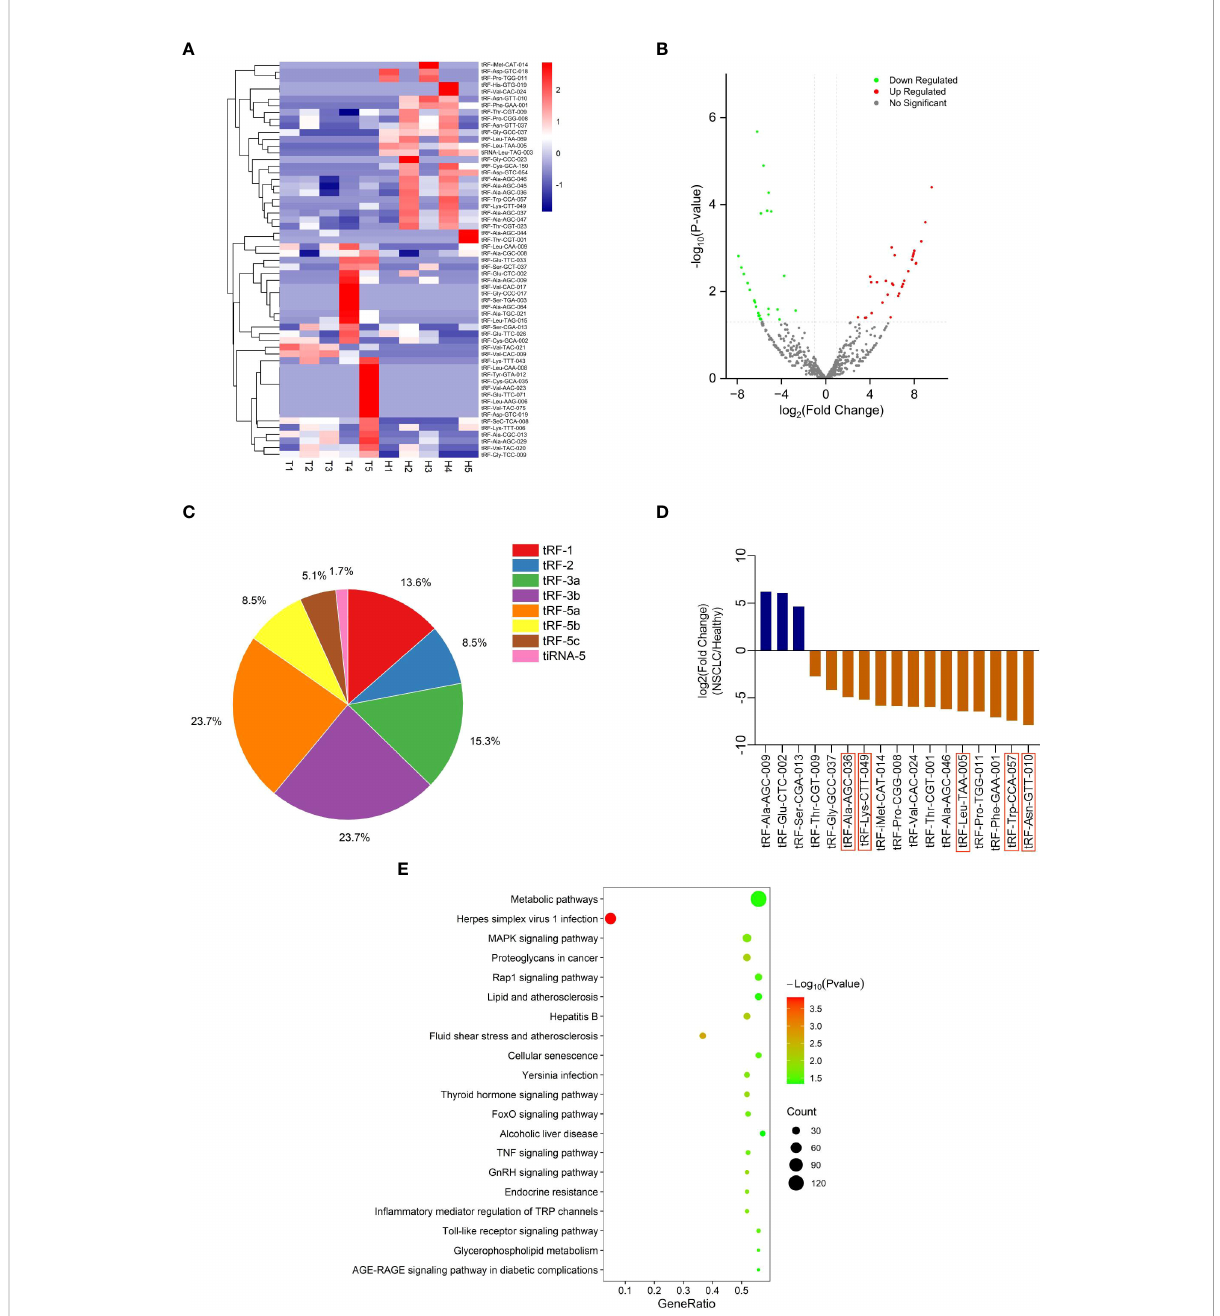
FIGURE 2 tRF pro fi ling of NSCLC patients and healthy individuals. (A) Cluster heatmap and (B) Volcano Plot of differential expression of plasma exosomal tRFs in 5 healthy individuals and 5 patients with NSCLC. (C) The proportion of each subtype of differentially expressed plasma exosomal tsRNAs. (D) The selected differential tRFs are shown in blue (up-regulated) and brown (down-regulated), and tRF-Leu-TAA-005, tRF-Asn-GTT-010, tRF- Ala-AGC-036, tRF-Lys-CTT-049, and tRF-Trp-CCA-057 are veri fi ed to be consistent with the sequencing results. (E) Pathway analysis of tRF- Leu-TAA-005, tRF-Asn-GTT-010, tRF-Ala-AGC-036, tRF-Lys-CTT-049, and